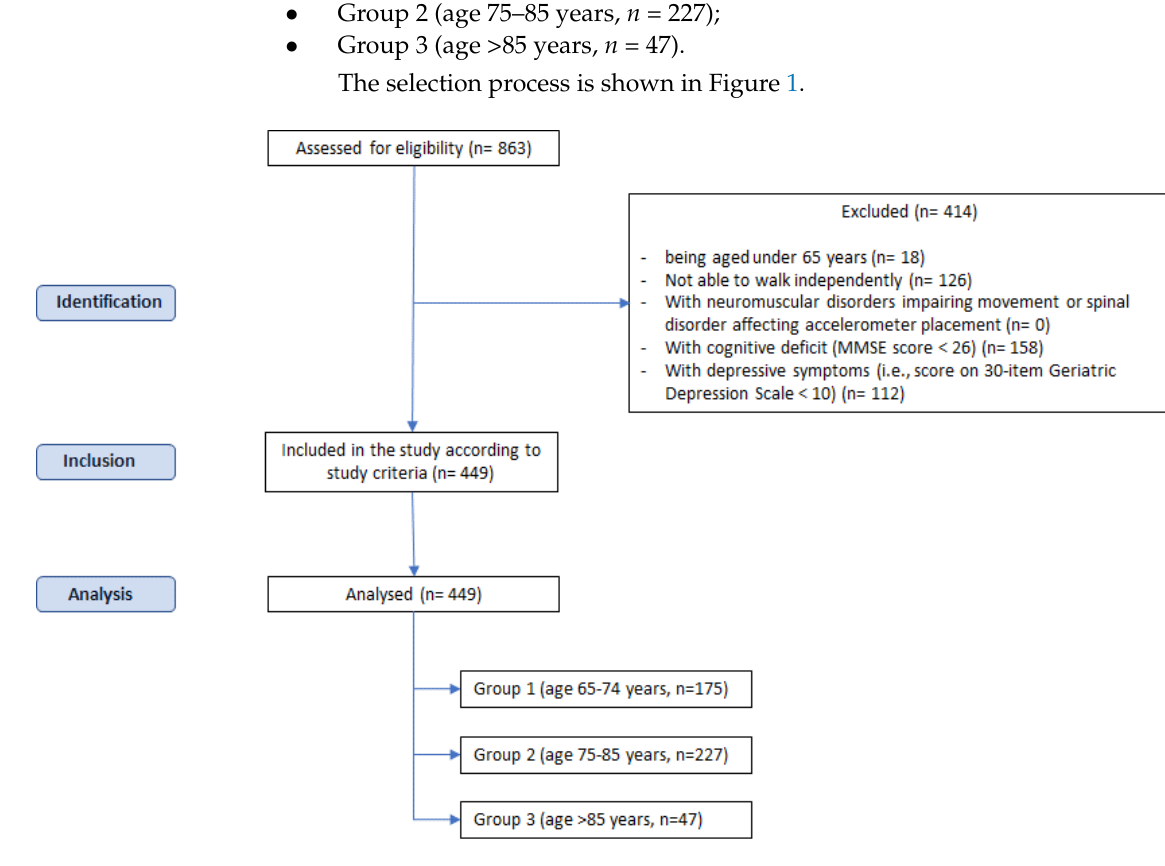
Figure 1. Process of participants’ selection.